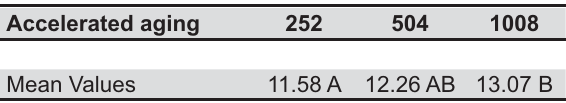
Table 4- (cid:2)(cid:3)(cid:4)(cid:5)(cid:6)(cid:2)(cid:7)(cid:5)(cid:8)(cid:9)(cid:4)(cid:10)(cid:2)(cid:11)(cid:12)(cid:2)(cid:17)!(cid:4)(cid:2)(cid:13)(cid:11)(cid:8)(cid:11)(cid:14)(cid:2)(cid:15)(cid:4)(cid:14)(cid:16)(cid:7)(cid:5)(cid:17)(cid:16)(cid:7)(cid:4)(cid:10)(cid:2)(cid:18)(cid:19)(cid:20)(cid:21)(cid:2)(cid:11)(cid:12)(cid:2)(cid:17)!(cid:4)(cid:2) two polishing techniques